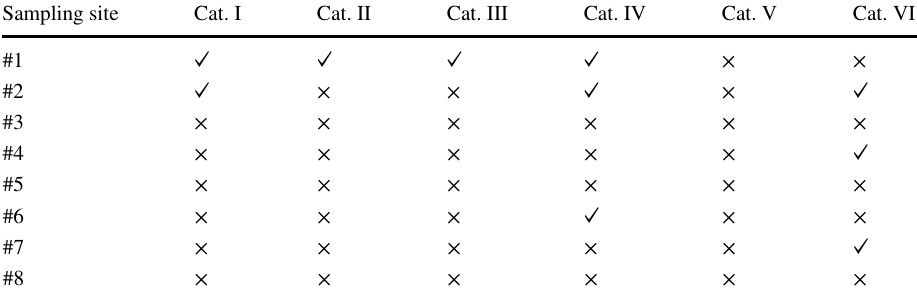
Table 9 Possible water uses at the sampling